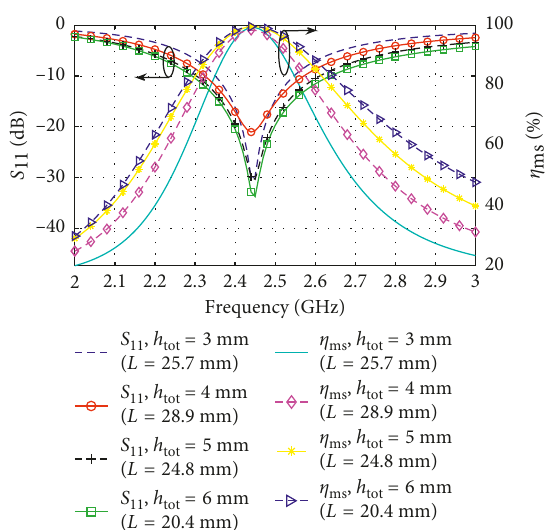
Figure 4: Simulated unit cell S 11 and efficiency as a function of the air gap h 2